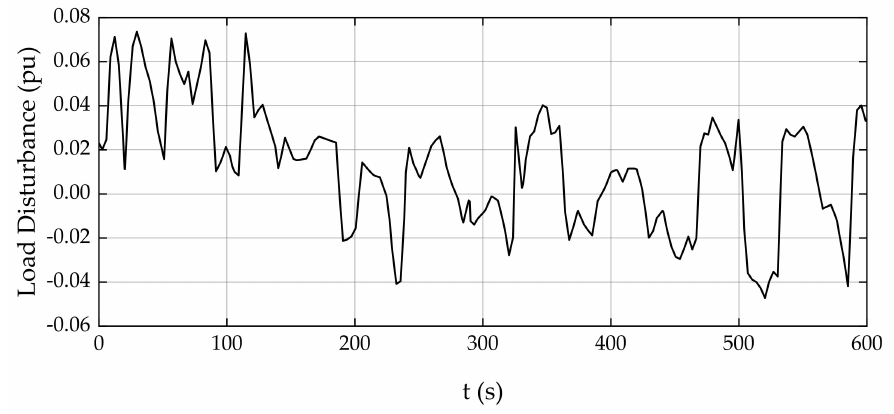
Figure 11. 10-min continuous load disturbance